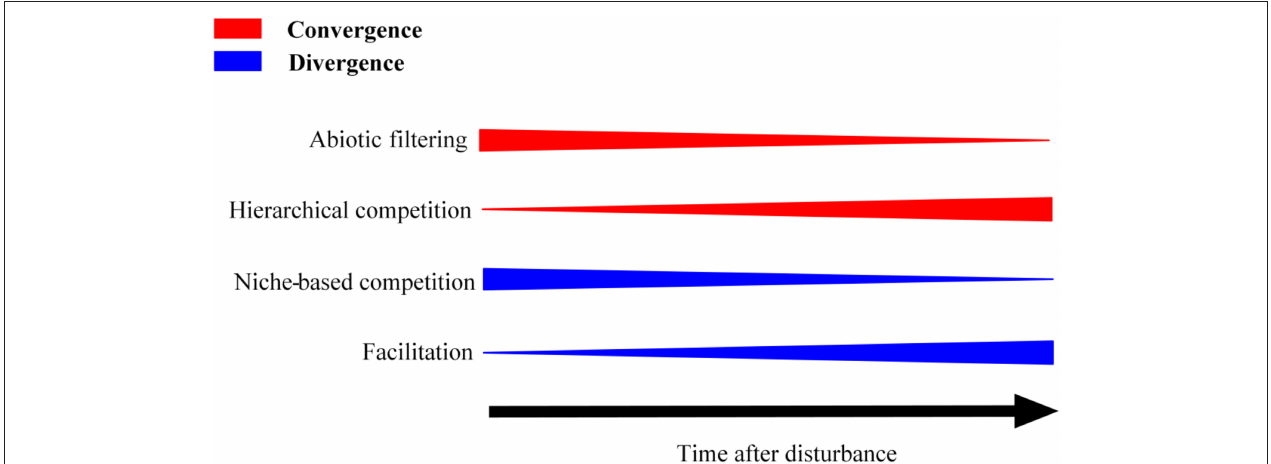
FIGURE 1 | Hypotheses concerning patterns in the relationship between trait dispersion (convergence and divergence) and community assembly processes during secondary